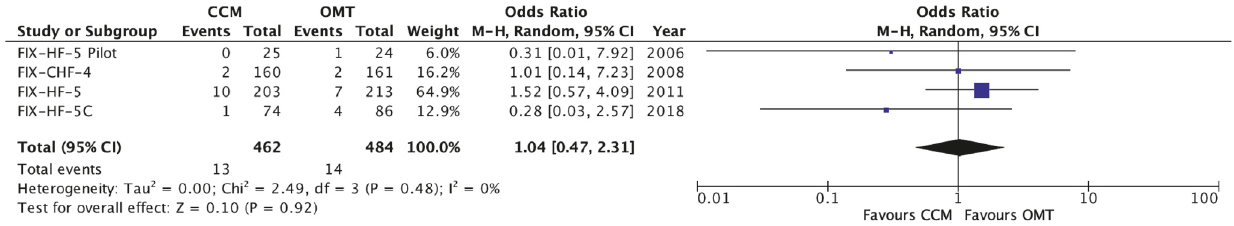
Figure 2: Forest plot of all-cause mortality (postrandomization/device implantation). A forest plot of the data available to us from the 4 RCTs assessing all-cause mortality in those with CCM compared to those with OMT alone. There was a nonsignificant difference in the rate of total hospitalizations between the two groups.